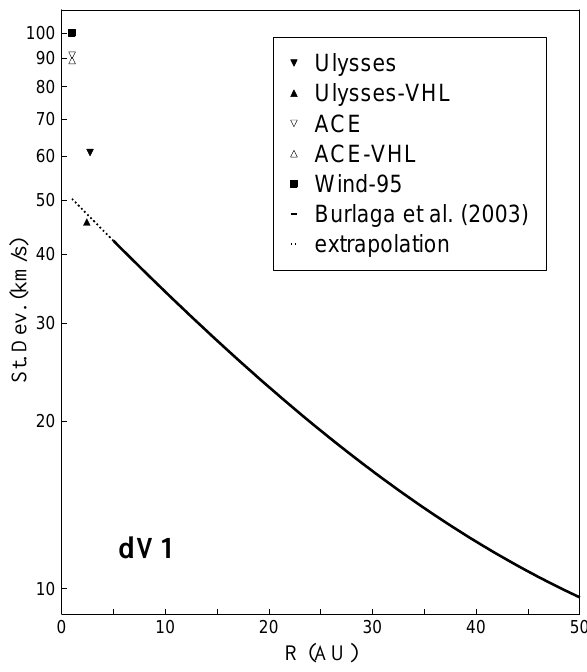
Fig. 9. The standard deviation as measured by Ulysses and by near- Earth spacecraft (ACE and Wind). The solid curve is from Burlaga et al. (2003), dots indicate an extrapolation to